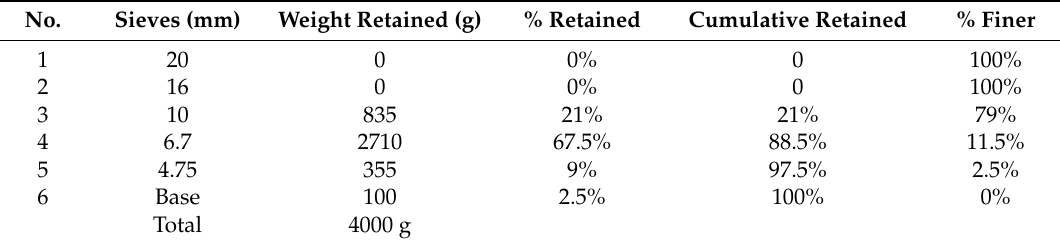
Table 2. Gradation of aggregates.